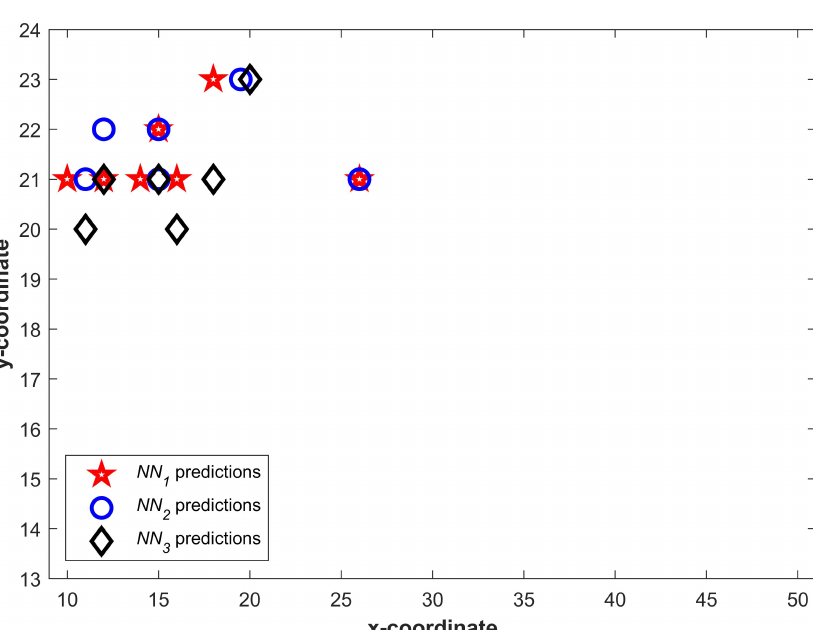
Figure 7. All predictions from neural networks drawn together.